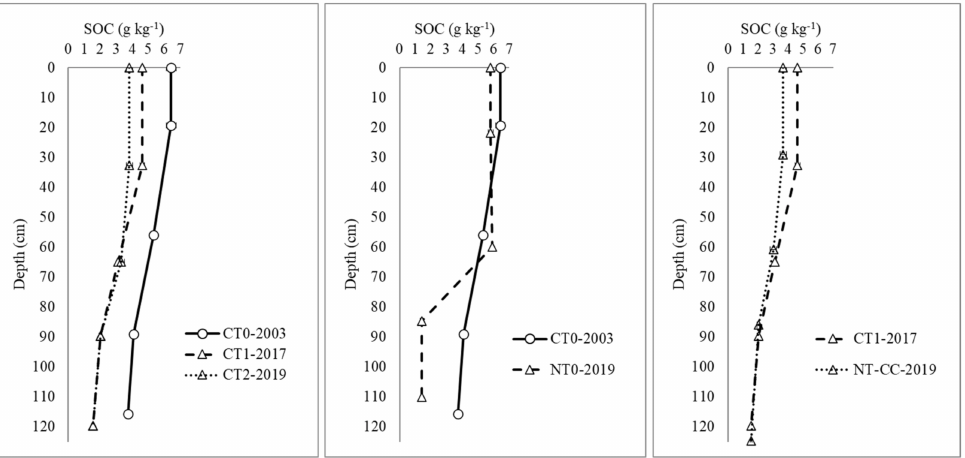
Figure 3. Soil organic carbon distribution in the study area. CT0: conventional tillage 2003, CT1: conventional tillage 2017, CT2: conventional tillage 2019, NT: conventional tillage 2019, NT-CC: no tillage with cover